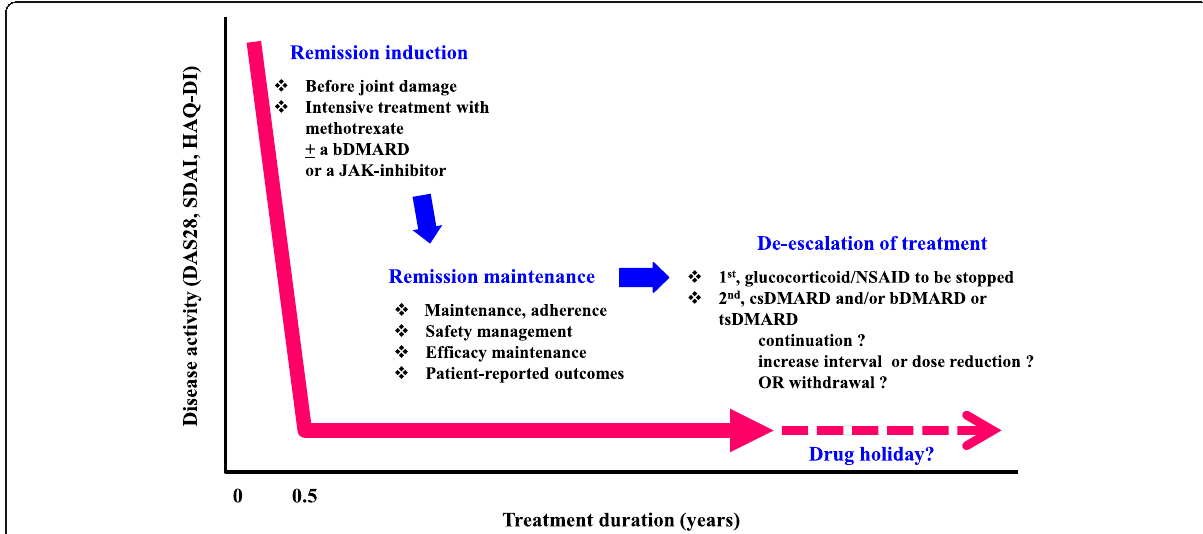
Fig. 3 Strategies for the treatment of rheumatoid arthritis. Intensive treatment is required for inducing remission in rheumatoid arthritis, but subsequently maintaining remission with high adherence and safety is a prerequisite for the good long-term outcome. The de-escalation and drug holiday of the DMARDs is an extension of the maintained